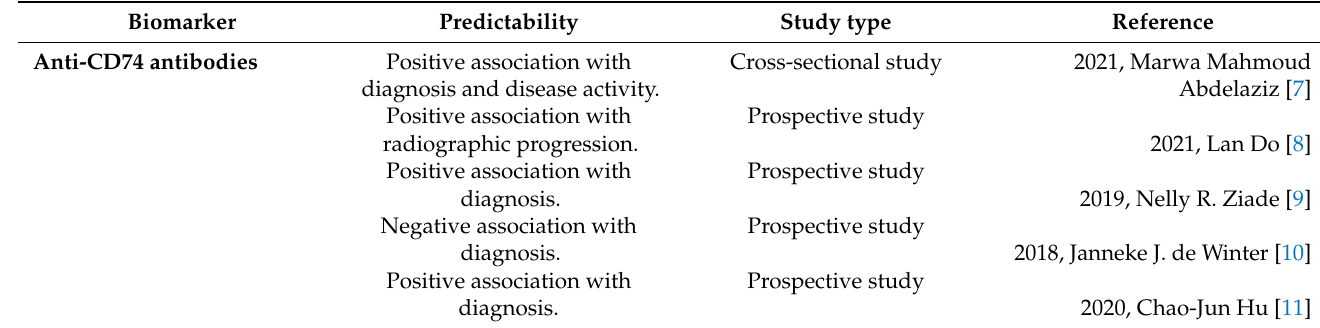
Table 1. Biomarkers significance in axial